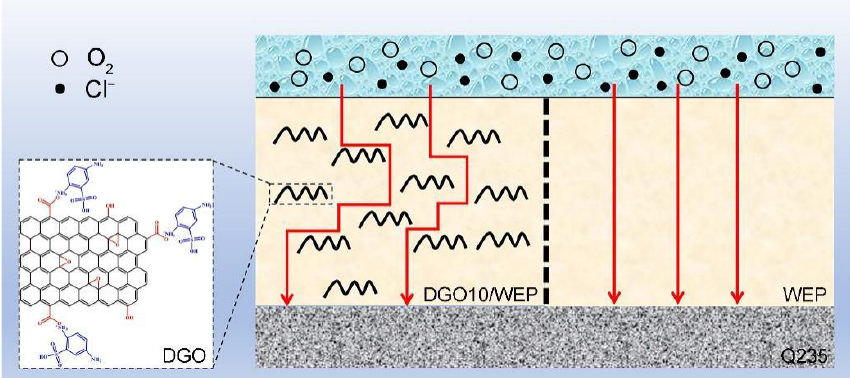
Figure 7. Schematic representation of the corrosion protection mechanism by DGO on Q235 steel substrates.